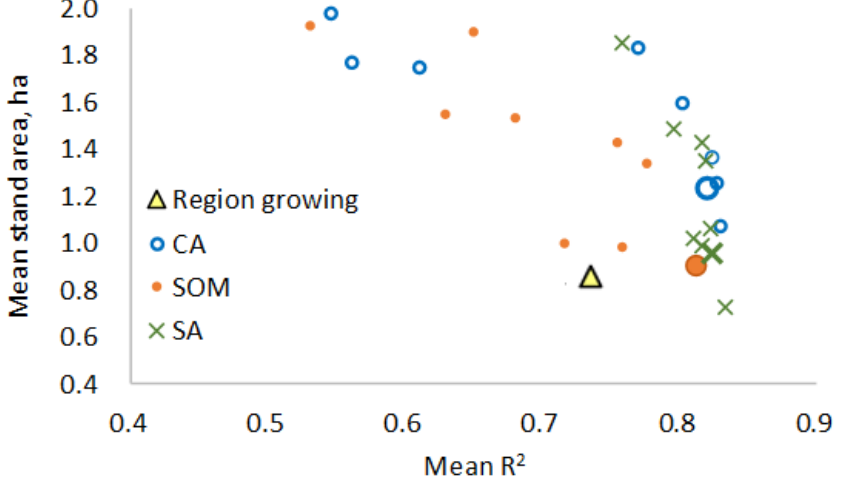
Figure 7. Relationship between the mean R 2 of the LiDAR metrics ( HP95 , AH5 , IV ) and the mean area of the segments when CA, SOM, and SA were used with different parameter values.